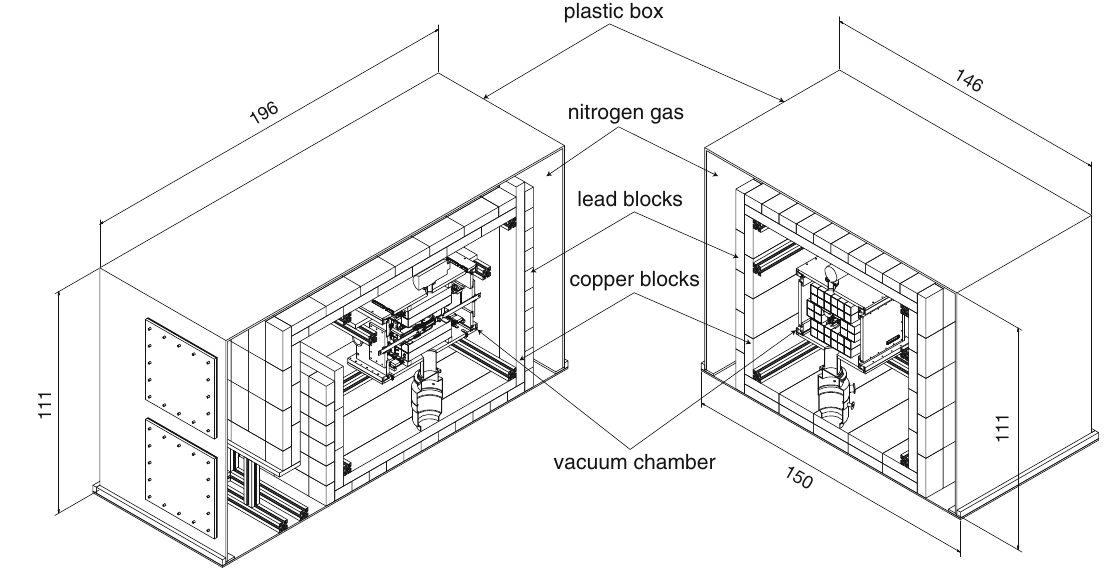
Fig. 3 Perspective views of the VIP-2 apparatus with passive shielding, with the dimensions in cm. Nitrogen gas with a slight over pressure with respect to the outside air will be circulated inside the plastic shielding